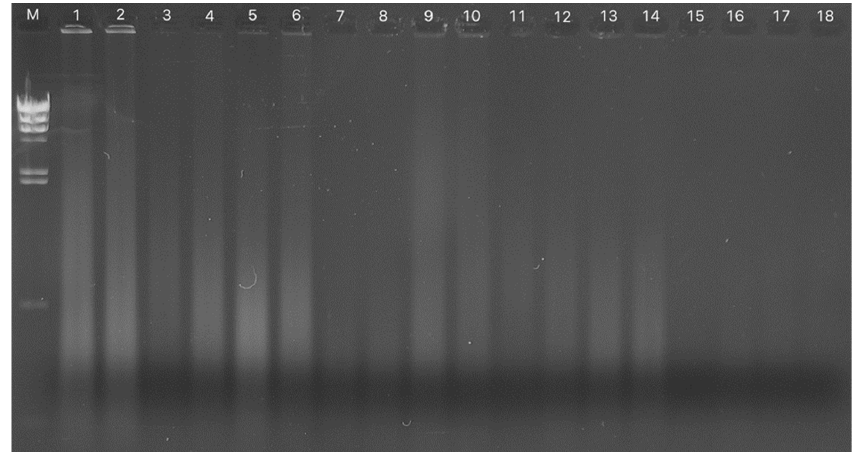
Figure 6. Lanes 1–18: Representative examples of DNA samples isolated from FFPE material.